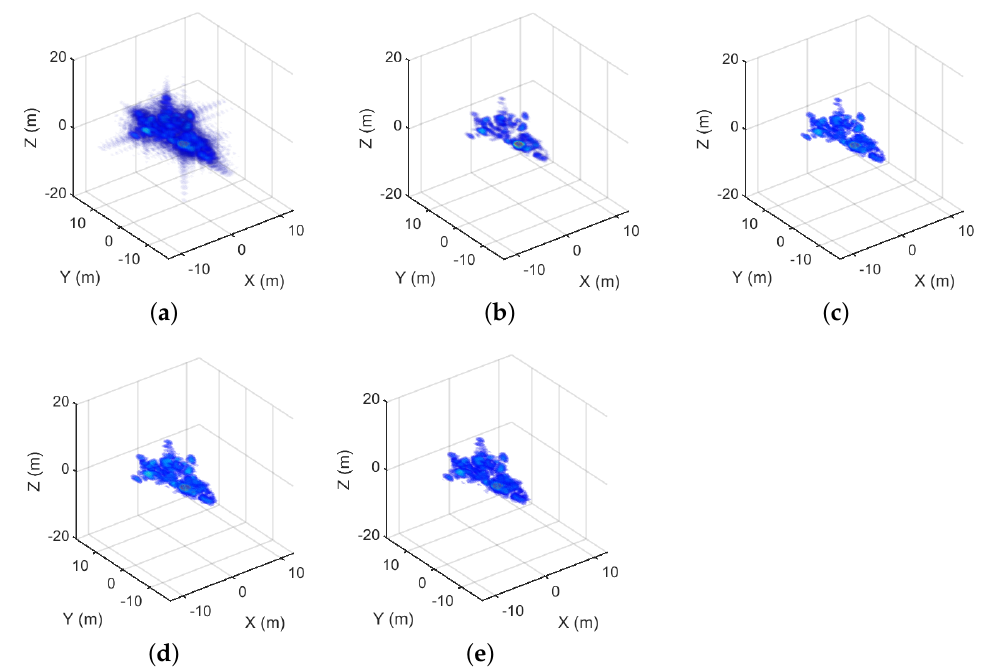
Figure 3. The imaging results of the aircraft with full sampling. ( a ) The MF result. ( b ) The FIST result. ( c ) The SCAD result. ( d ) The MCP result. ( e ) The GSALSA–Cauchy result.